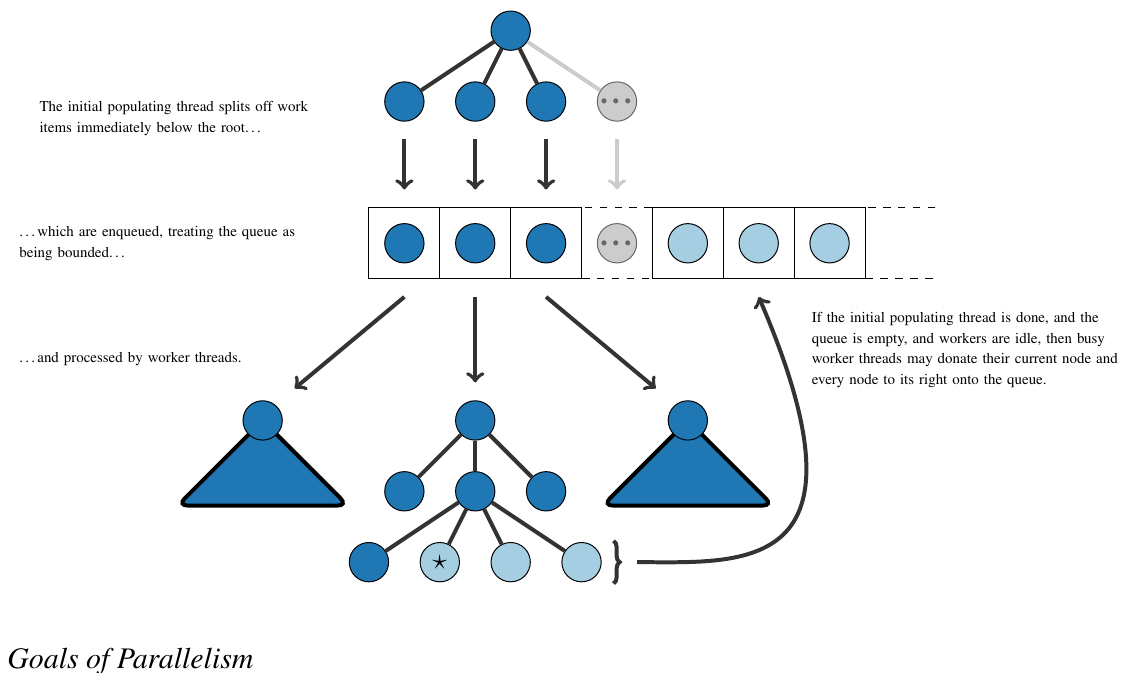
Figure 2. Work splitting and queueing mechanism for our parallel algorithm. Nodes correspond to a call to expand . Work donation occurs once when the donating worker’s position is at the node marked (cid:63)